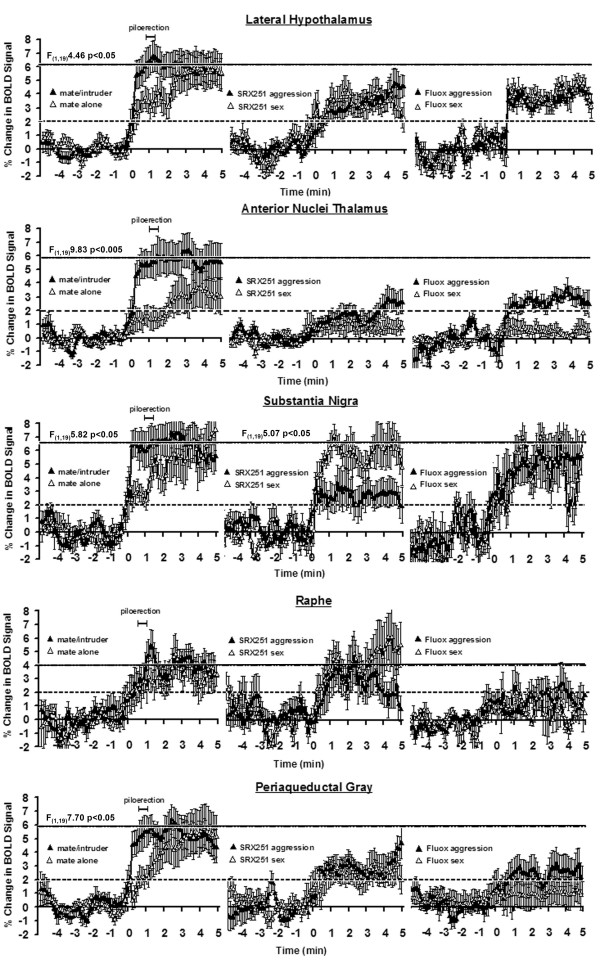
Change in BOLD signal over time. Shown are representative time course data from select brain areas depicting the change in BOLD signal following stimulus presentation (time 0 min). For each brain area the data in response to mate alone or mate/intruder are presented on the left column while the data from mate/intruder (aggression) or novel receptive female (sex) in the presence of SRX251 or fluoxetine are presented in the middle and right columns. The dashed horizontal line marks the threshold of 2% below which is baseline noise in awake imaging studies. The solid line at top represents the approximate BOLD signal change for aggressive motivation alone. The scale marked piloerection shows the range of time (62 ± 11) for piloerection following introduction of the mate/intruder into the vivarium. The percentage change in BOLD signal intensity at each time point (100 data acquisition over the 10 min scanning period) is the average of 10 male residents for each experimental condition. Vertical lines at each data point denote the standard error of the mean. Where show, the F values represent significant differences between experimental conditions based on a repeated measured 2-way ANOVA for the 1st min post stimulation.